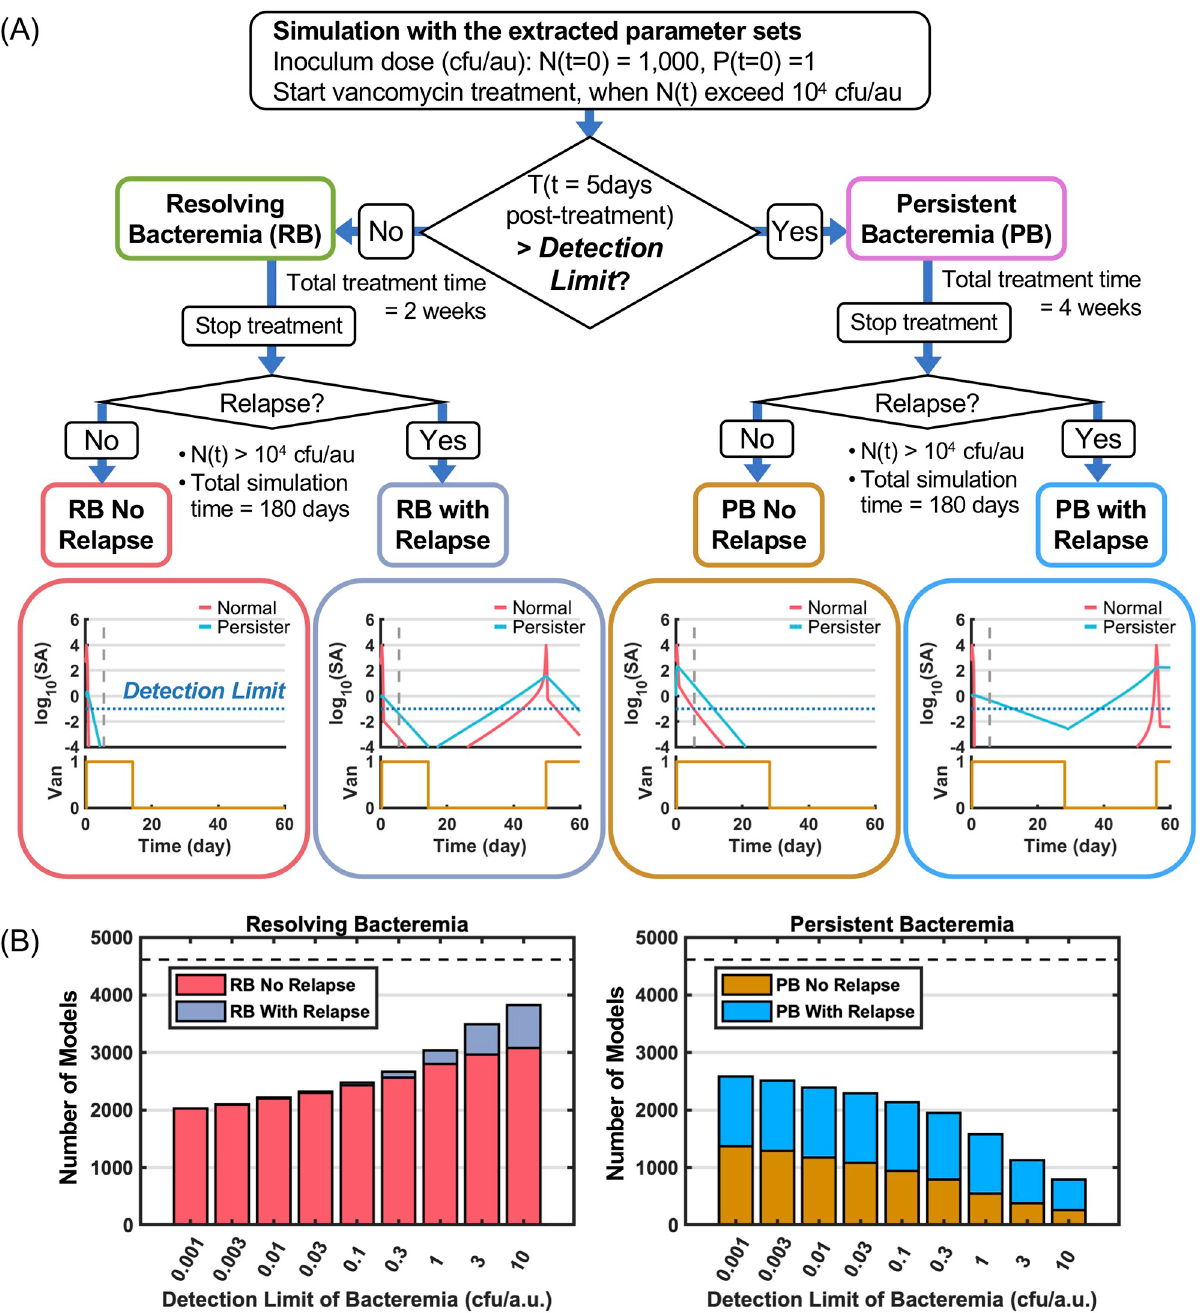
Fig 3. Simulation of the models with vancomycin therapy. (A) The selected parameter sets were used for simulation with vancomycin treatment and classified into resolving (RB) and persistent bacteremia (PB) as described in the algorithm. Vancomycin was administered when normal SA ( N ) exceeded 10 4 cfu/a.u. The models were judged as PB when the number of total SA ( T ) at 5 days post-treatment exceeded a detection limit under an assumption where positive bacteremia is observed when the number of SA at infection foci exceed a certain number (see text in details). The detection limit of bacteremia is set as 0.1 cfu/a.u. in this study under an assumption where relapse bacteremia is less in RB (see Fig 3B). The relapse bacteremia was determined when vancomycin was re-administered triggered by regrowth of SA after 1 st vancomycin treatment. Four cases of typical simulations, RB no relapse, RB with relapse, PB no relapse and PB with relapse, are shown in the bottom. (B) Bar plots show the number of models with or without relapse for RB (left) and PB (right) over a range of detection limit from 0.001 to 10 cfu/a.u. A dotted line indicates the total number of models.